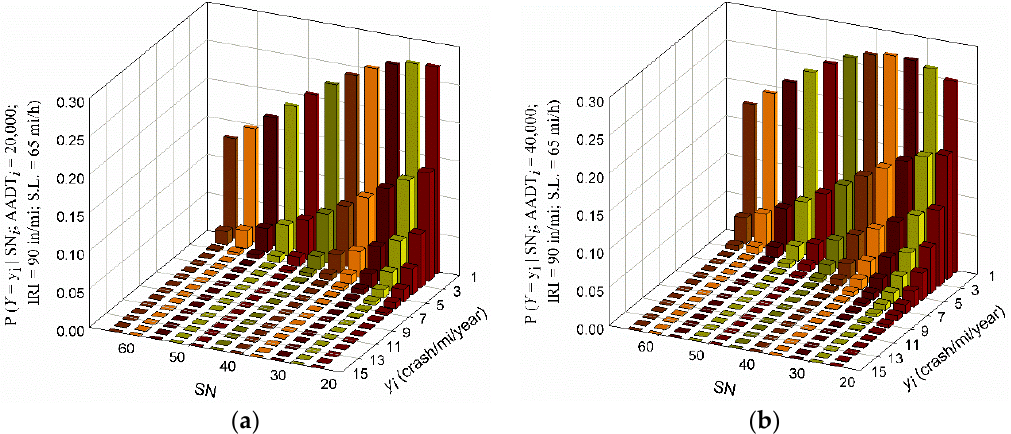
Figure 8. Probability mass function using fitted general model parameters for varying SN; ( a ) 20,000 AADT and ( b ) 40,000 AADT; and fixed IRI and SL.